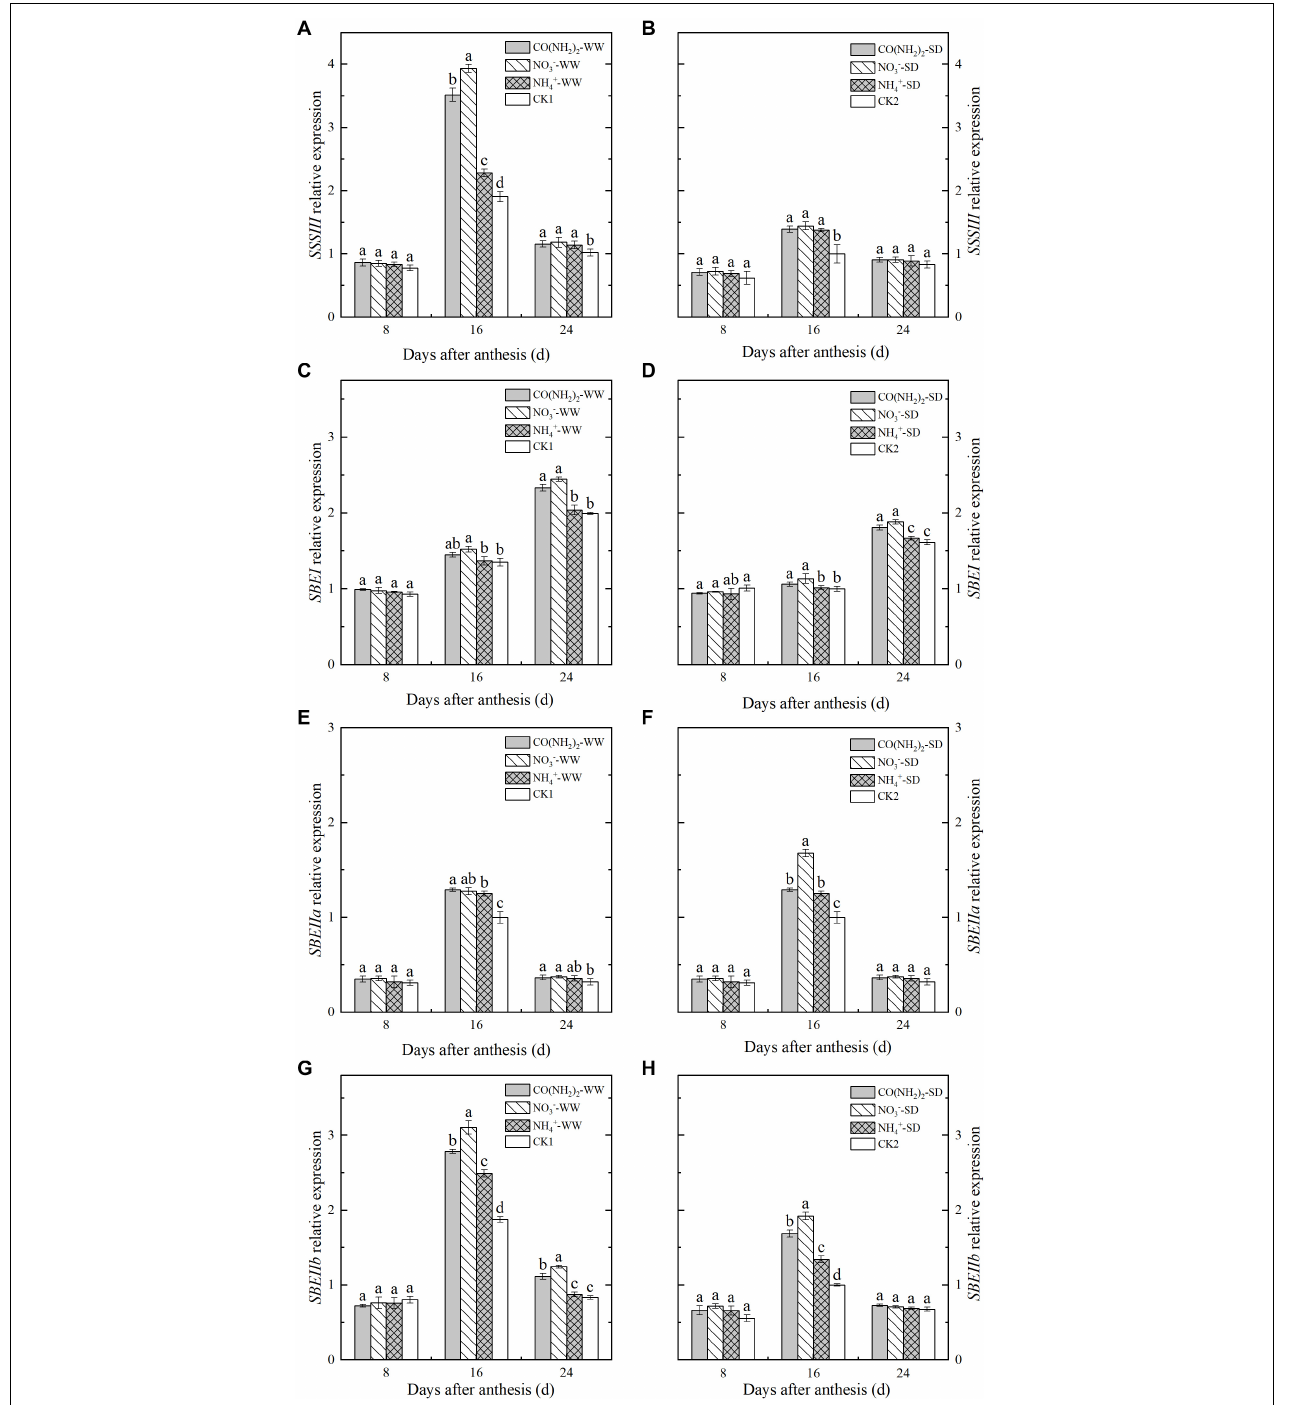
FIGURE 6 | Effect of N forms in foliar fertilizer on the relative expression of SSSII, SBEI, SBEIIa, and SBEIIb enzyme genes in the wheat grains [ (A,C,E,G) well-watered treatment, WW; (B,D,F,H) soil-dried treatment, SD]. Vertical bars represent ± the standard deviation of the mean ( n = 3). CO(NH 2 ) 2 , NO 3 − , and NH 4 + represent CO(NH 2 ) 2 , NaNO 3 , and NH 4 Cl, whose concentration was described in the Materials and Methods section. CK1 and CK2 mean that deionized water was sprayed on leaves at anthesis under well-watered treatment and soil-dried treatment, respectively. Values followed by the same letters in each soil moisture are not significantly different at P < 0.05